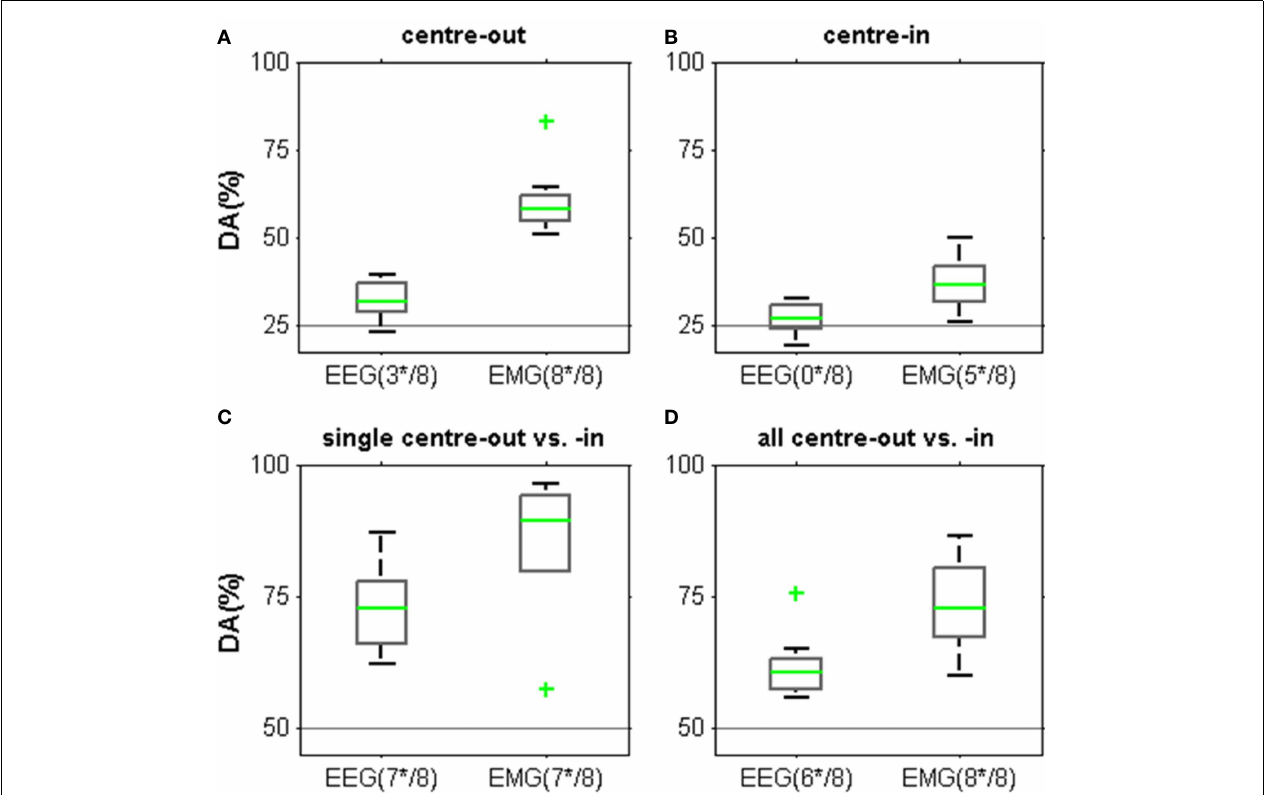
FIGURE 8 | Decoding endpoints of arm movements from the MER2a EEG component and from arm-muscle EMG, both for a time window at approximately 1s after movement end (c.f. Figure 7). Horizontal lines indicate chance level.The number of subjects with significant DA is indicated below each box plot (e.g., “(3 ∗ /8)” = 3 of the 8 subjects). Box plot whiskers extend to DAs within 1.5 times the inter-quartile range, the median, and outliers are indicated in green. (A) Decoding results for the endpoints of center-out movements. EEG-based DA was significantly above chance in three subjects. EMG-based DA was significant in all subjects. (B) Decoding